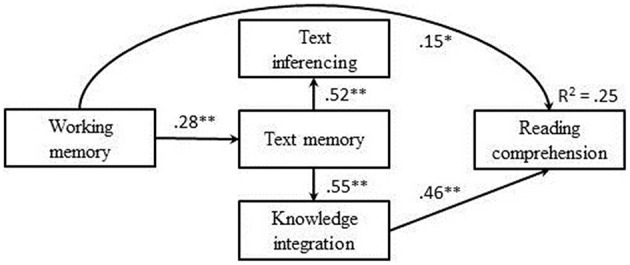
Final model, including the standardized estimates of the variables influencing reading comprehension performance, the significant pathways are indicated with an asterisk, *p < 0.05, **p < 0.01.